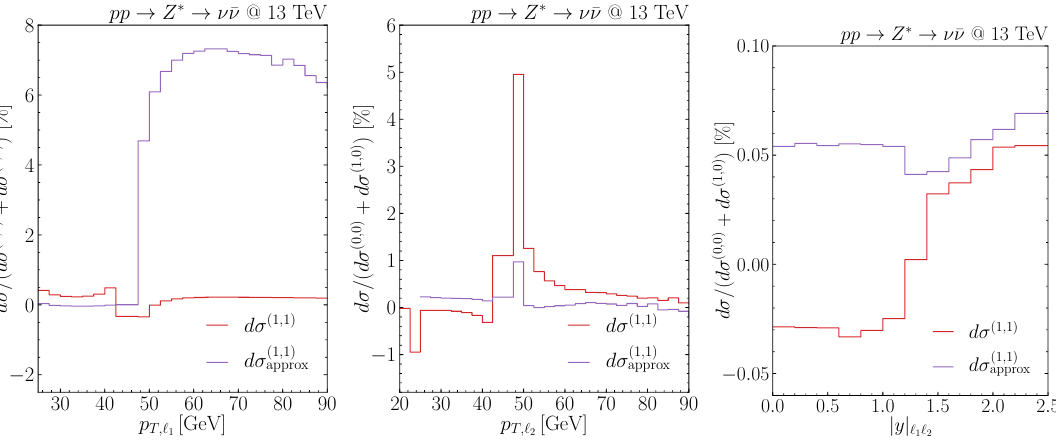
Figure 5 . Comparison between the mixed QCD (cid:10) QED corrections (red) and the naive factorisation approximation (purple), for the transverse momentum of the hardest (left) and softer (center) lepton, and the rapidity of the pair